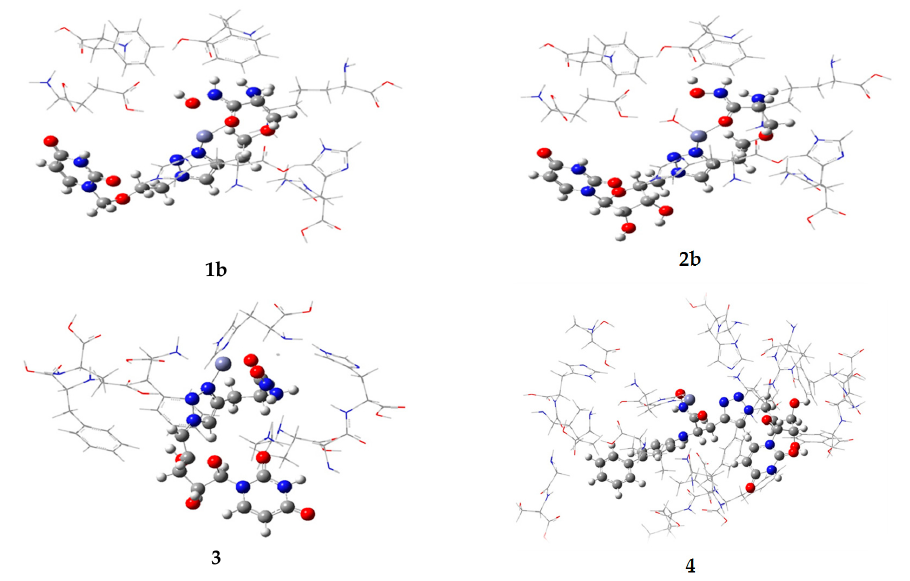
Figure 3. Optimized conformations of conjugates 1b , 2b , 3 and 4 in the truncated LpxC active site. The purple atom is Zn 2+ . Conjugates 1b and 2b were optimized in vacuo, while 3 and 4 were evaluated in the solvated model.